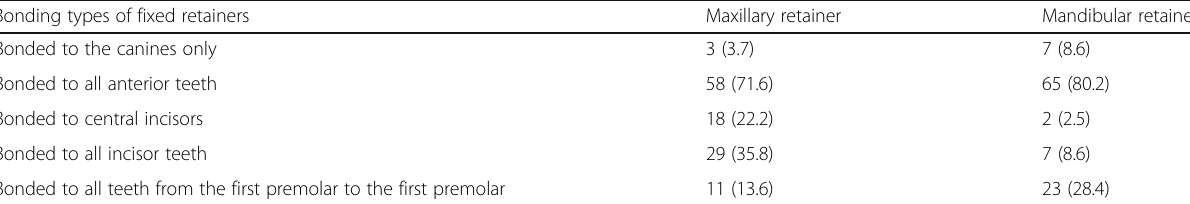
Table 3 Respondents who chose a certain bonding type of fixed retainers Bonding types of fixed retainers